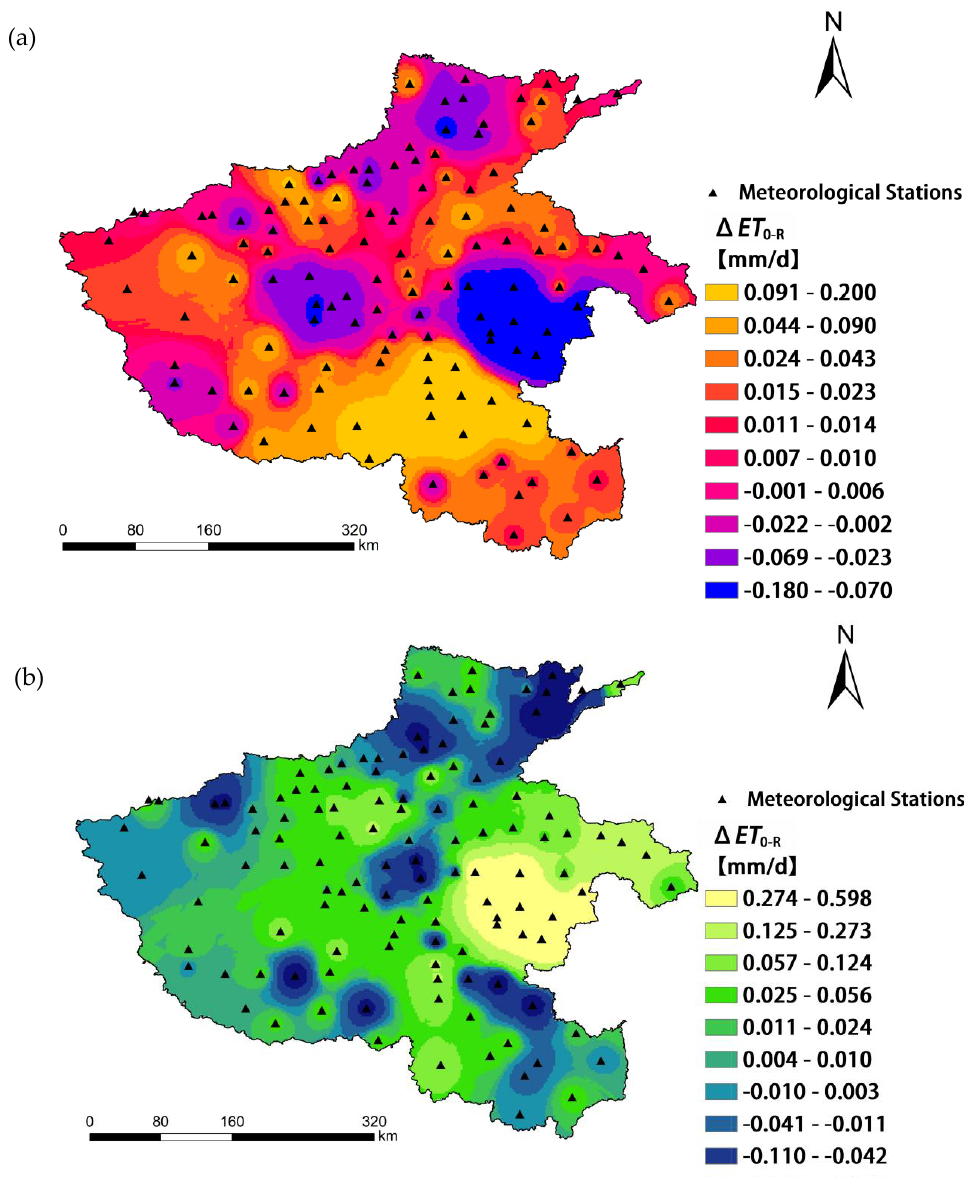
Figure 7. The effect of aerosol on the ET 0 radiation term ( a ) and aerodynamic term ( b ).